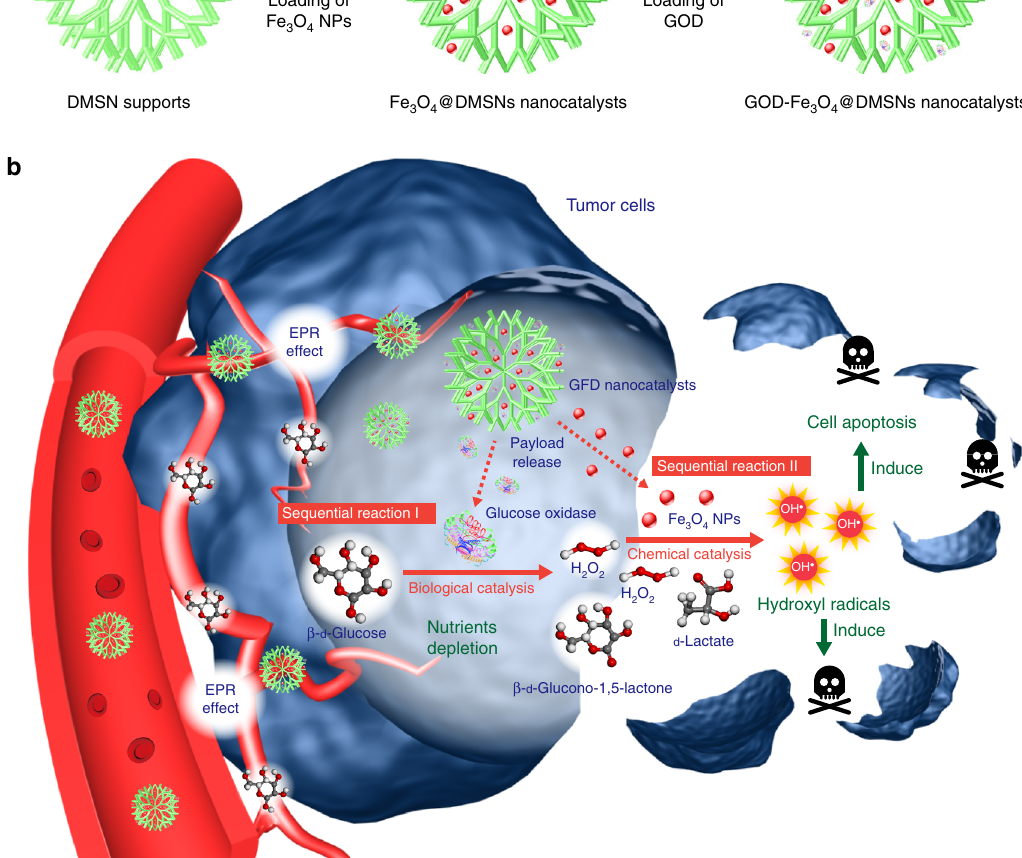
Fig. 1 Fabrication and catalytic-therapeutic schematics of sequential GFD NCs. a Synthetic procedure for Fe 3 O 4 @DMSNs nanocatalysts and GOD- Fe 3 O 4 @DMSNs nanocatalysts. The sizes of the prepared Fe 3 O 4 nanoparticles and adopted GOD are indicated in the scheme. b The scheme of sequential catalytic-therapeutic mechanism of GFD NCs on the generation of hydroxyl radicals for cancer